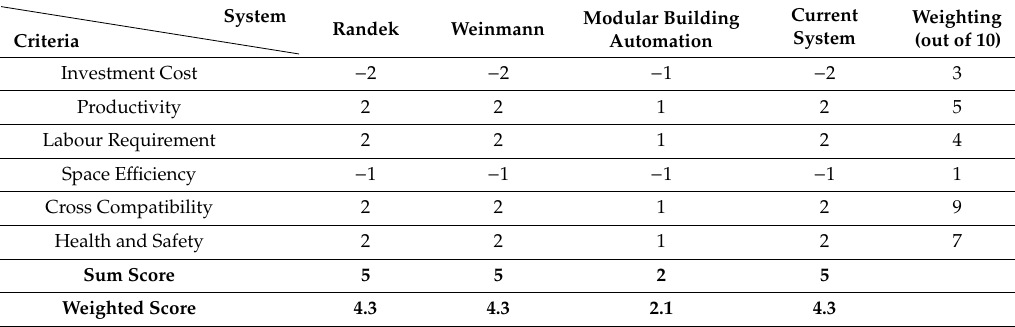
Table 12. Resultant scores for bu ff er